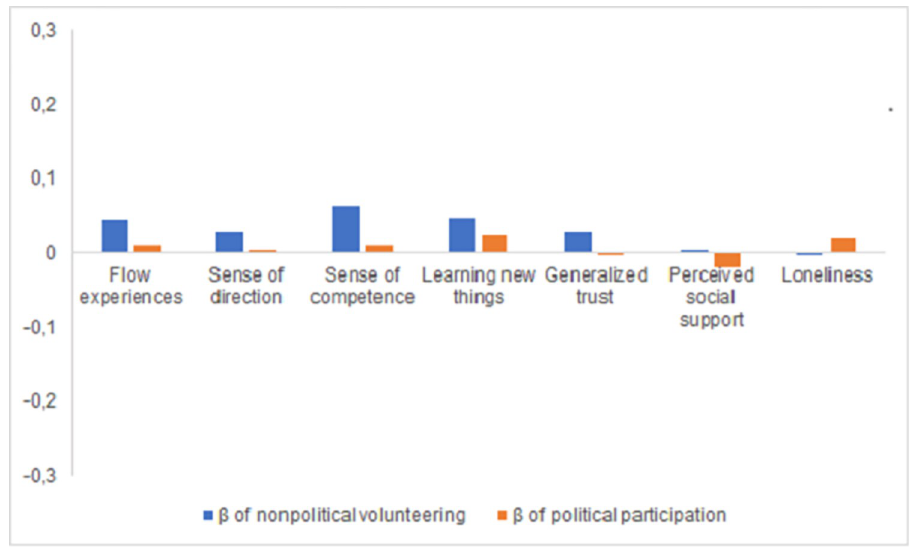
Fig 1. Standardized effects of nonpolitical volunteering and political participation on well-being outcomes in comparison. Within each pair, effects significantly differ at p < .01.